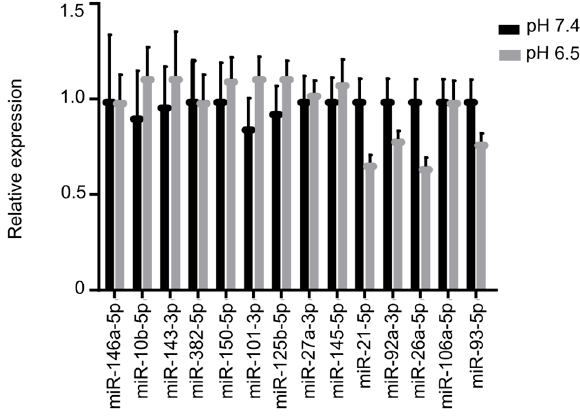
Figure 5. EVs cargo: angiogenesis-related miRNA. Real Time PCR analysis of the expression of angiogenesis-related miRNA in OS-derived EVs maintained at acidic or neutral pH (mean ± SE, n = 3, Mann–Whitney test).